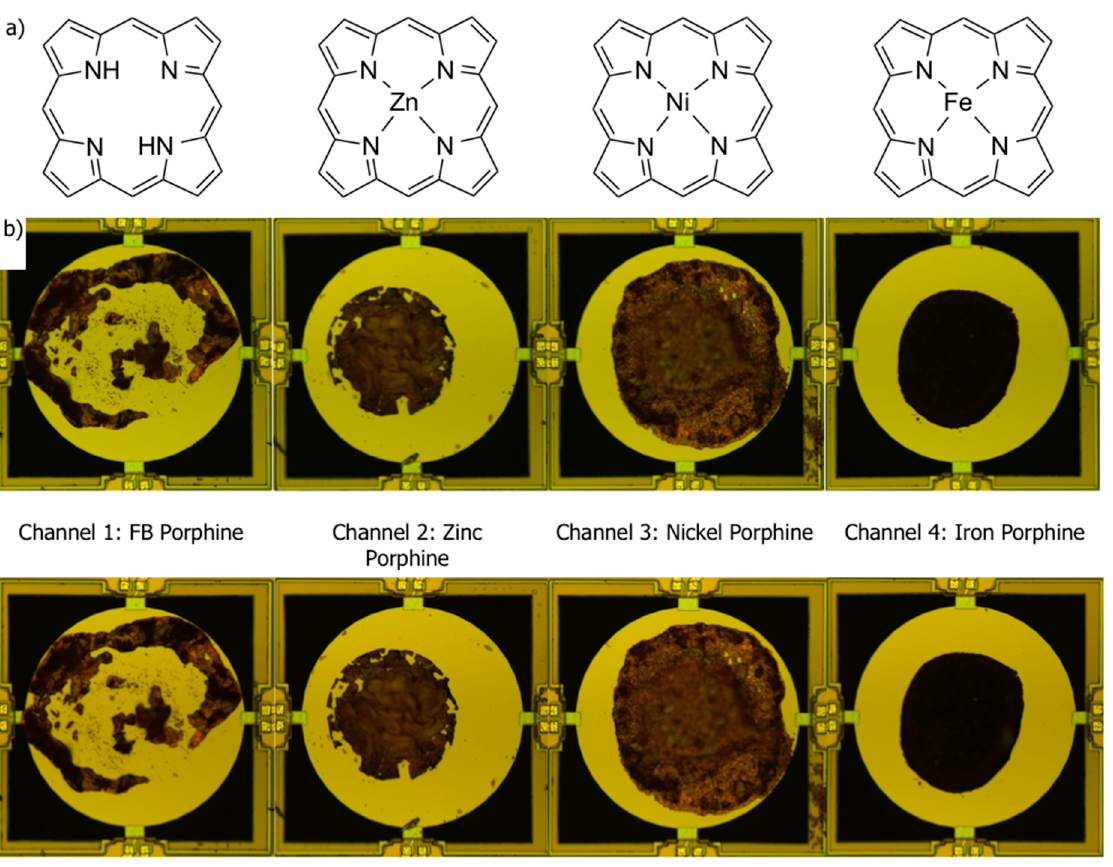
Figure 2. Porphine-based receptor materials coated on MSS channels. ( a ) Structures of free-base and metal coordinated porphines; ( b ) Optical microscope images of each MSS channel coated with porphines before (upper) and after (bottom) gas sensing measurements. Channel 1, free-base (FB) porphine; Channel 2, zinc porphine; Channel 3, nickel porphine; Channel 4, iron porphine.